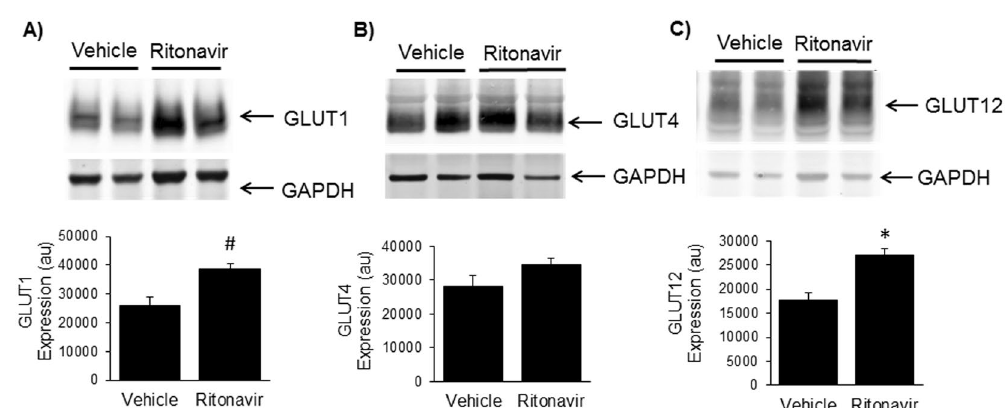
Figure 7. Effects of Chronic Ritonavir Treatment on GLUT Protein Expression by Left Ventricle. Protein expression of ( A ) GLUT1, ( B ) GLUT4, and ( C ) GLUT12 was determined in 75 day old male TG9 mice, treated with vehicle or ritonavir since 6 weeks of age, by Western Blot analysis as described in Methods. Western blots are representative data for n = 6 animals/group. Representative full-length blots are presented in Supplementary Fig. 1. Quantitative data are normalized to GAPDH controls and are shown as means ± SEM for n = 6 animals/ group * p < 0.01 vs. Veh, # p < 0.05 vs.